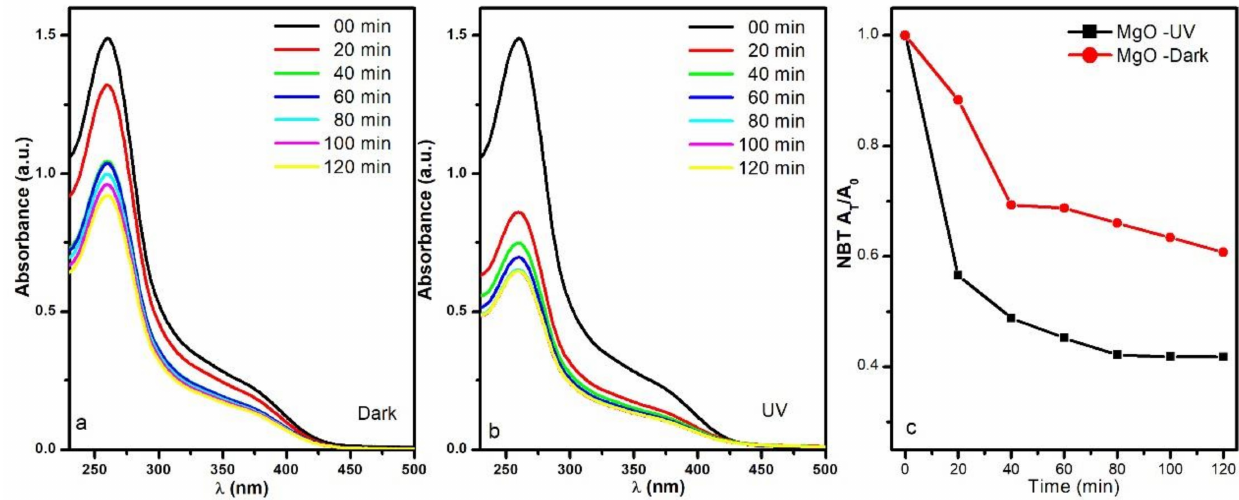
Figure 8. UV–Vis spectra of nitro blue tetrazolium (NBT) in nano MgO under ( a ) dark and ( b ) UV irradiation, and ( c ) the degradation kinetics of NBT in the dark and with UV